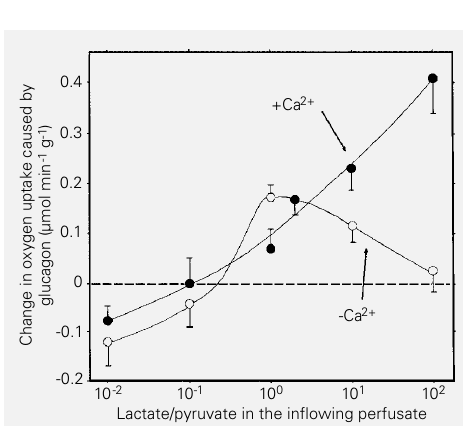
Figure 4 - Changes in gluconeogenesis caused by glu- cagon in the presence (filled circles) and absence (open circles) of Ca 2+ and at different cytosolic NAD + -NADH redox potentials. Livers from fasted rats were perfused as described in Material and Methods and as illustrated in Figure 1. The changes in gluconeogenesis caused by glucagon are the differences between the new steady state in the presence of glucagon and the steady state in the absence of glucagon. Each data point represents the mean of 3 to 5 liver perfusion experiments. The vertical bars represent the standard errors of the mean. For the control curve (filled circles), the traced curve corresponds to a parabolic regression line, optimized by means of a least-squares procedure. The regression line was y ^ = 0.0245 - 0.0637x + 0.031x 2 , with x = log (lactate/pyruvate x 10 3 ). The parabolic correlation coef- ficient was 0.987.